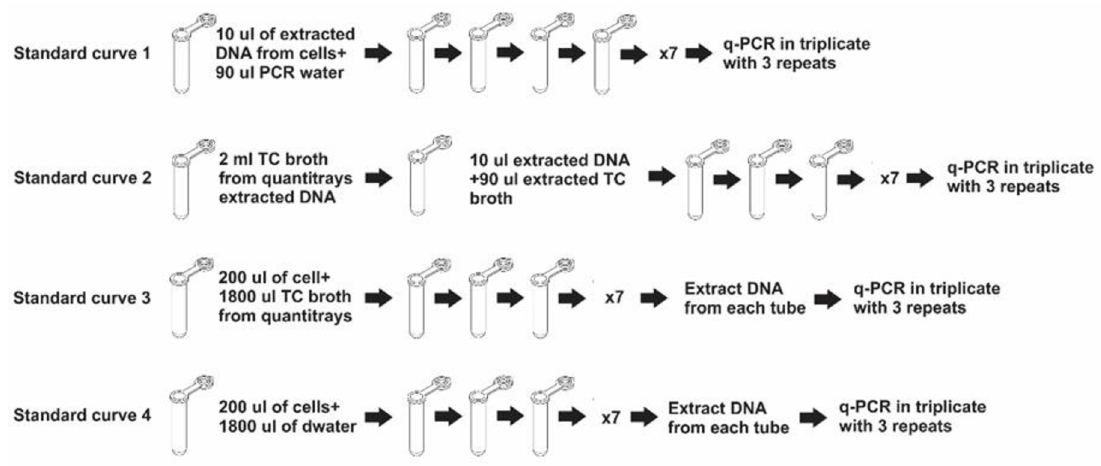
Fig 1. Schematic representation of how the standard curves were constructed.